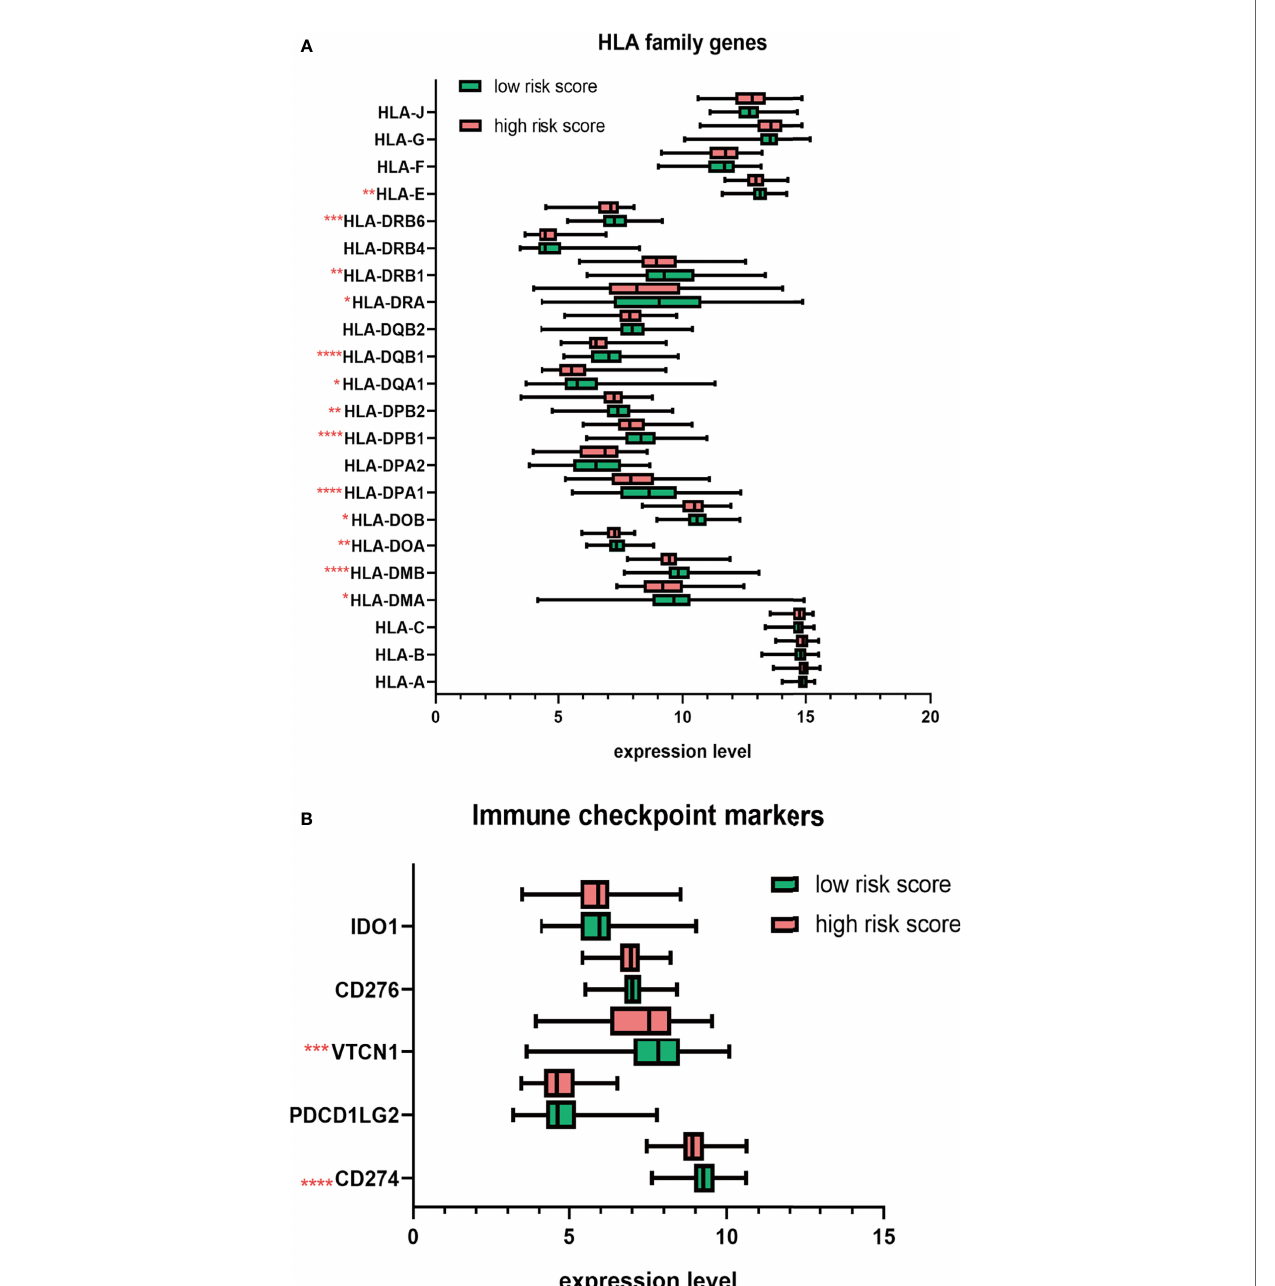
FIGURE 8 | The distribution HLA family genes and immune checkpoint markers between the high- and low-risk MM patients. (A) Boxplot of HLA family genes. (B) Boxplot of immune checkpoint markers. * p < 0.05, ** p < 0.01, *** p < 0.001, **** p <